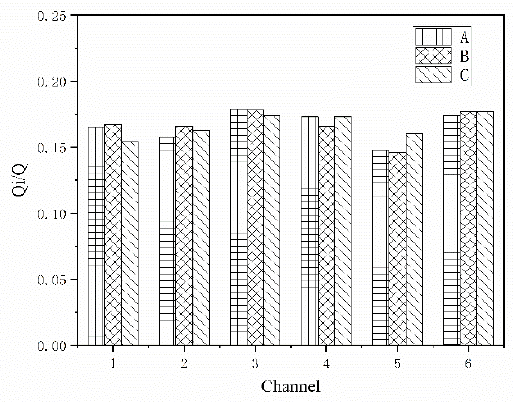
Figure 12. Flowrates distribution among rotor channels.